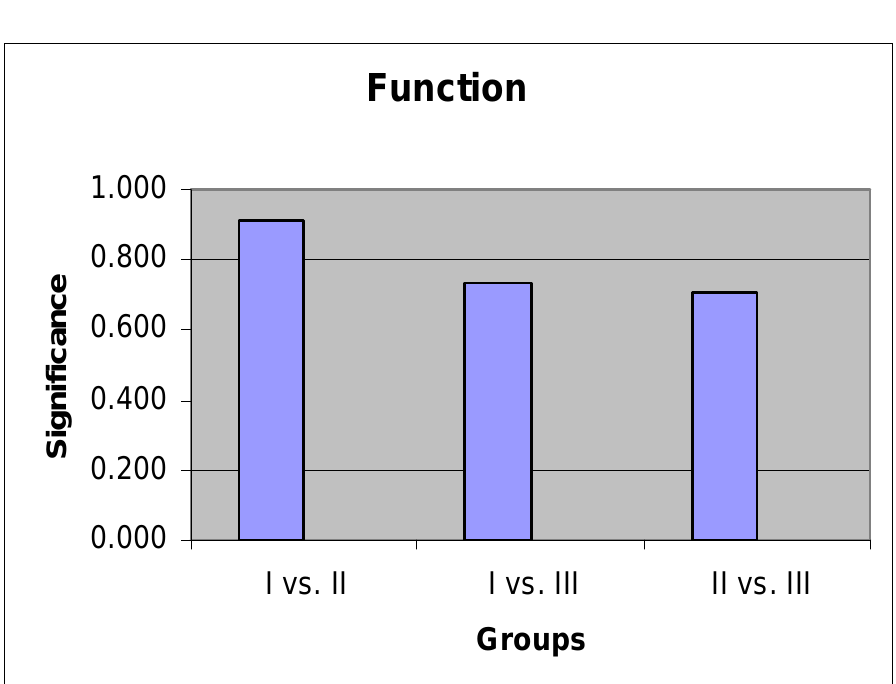
FIGURE 4. Function variation between